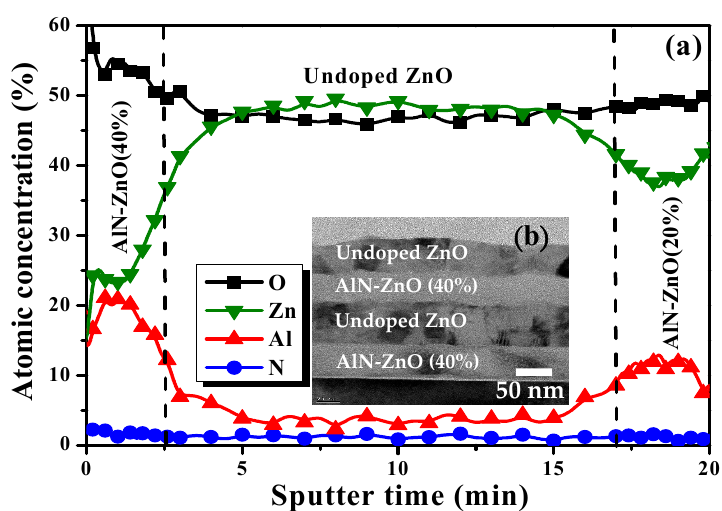
Figure 9. ( a ) Elemental depth profiles of the AlN-ZnO (20%)/ZnO/AlN-ZnO (40%) double heterojunction structure from Auger electron spectroscopy (AES) measurement (( b ) symmetric AlN-ZnO (40%)/ZnO/AlN-ZnO (40%) DH structure conducted from the cross-sectional TEM observations).